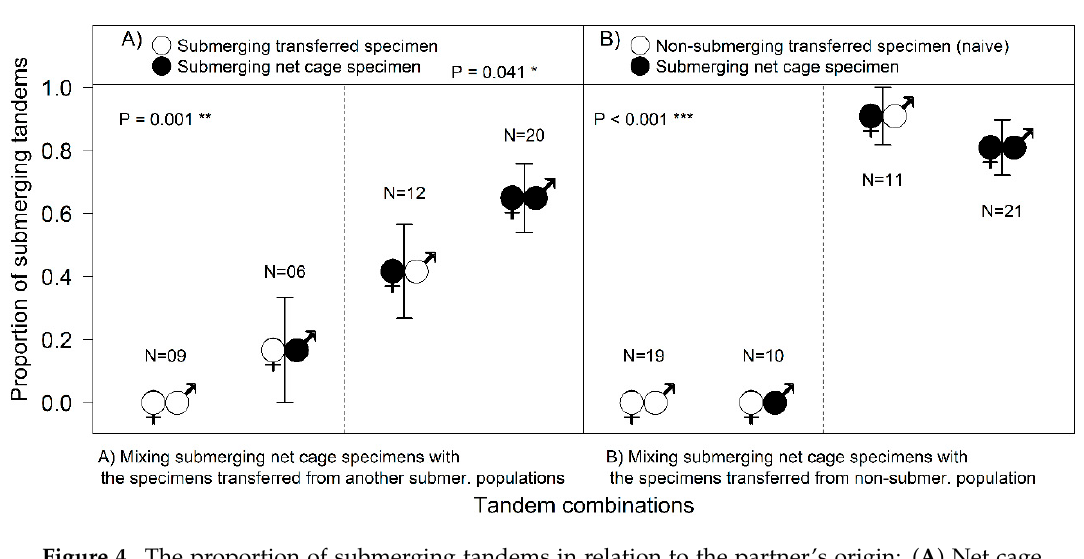
Figure 4. The proportion of submerging tandems in relation to the partner’s origin: ( A ) Net cage submerging specimens combined with submerging-experienced specimens from another submerging locality; ( B ) net cage submerging specimens combined with naive specimens from non-submerging locality. The female’s origin is crucial for the occurrence of submerging behaviour. Net cage females had greater proportion of submerged oviposition when combined with naive males than with transferred submerging males (d f = 104, χ 2 = 4.19, p = 0.041). Net cage females had much greater proportion of submerged oviposition regardless of the male origin (d f = 104, χ 2 = 64.04, p < 0.001) than the transferred females. This pattern was valid also for Figure 4A,B, tested separately (d f = 43, χ 2 = 15.82, p = 0.001; d f = 57, χ 2 = 56.61, p < 0.001, respectively). All analyses were performed by binomial GLM.